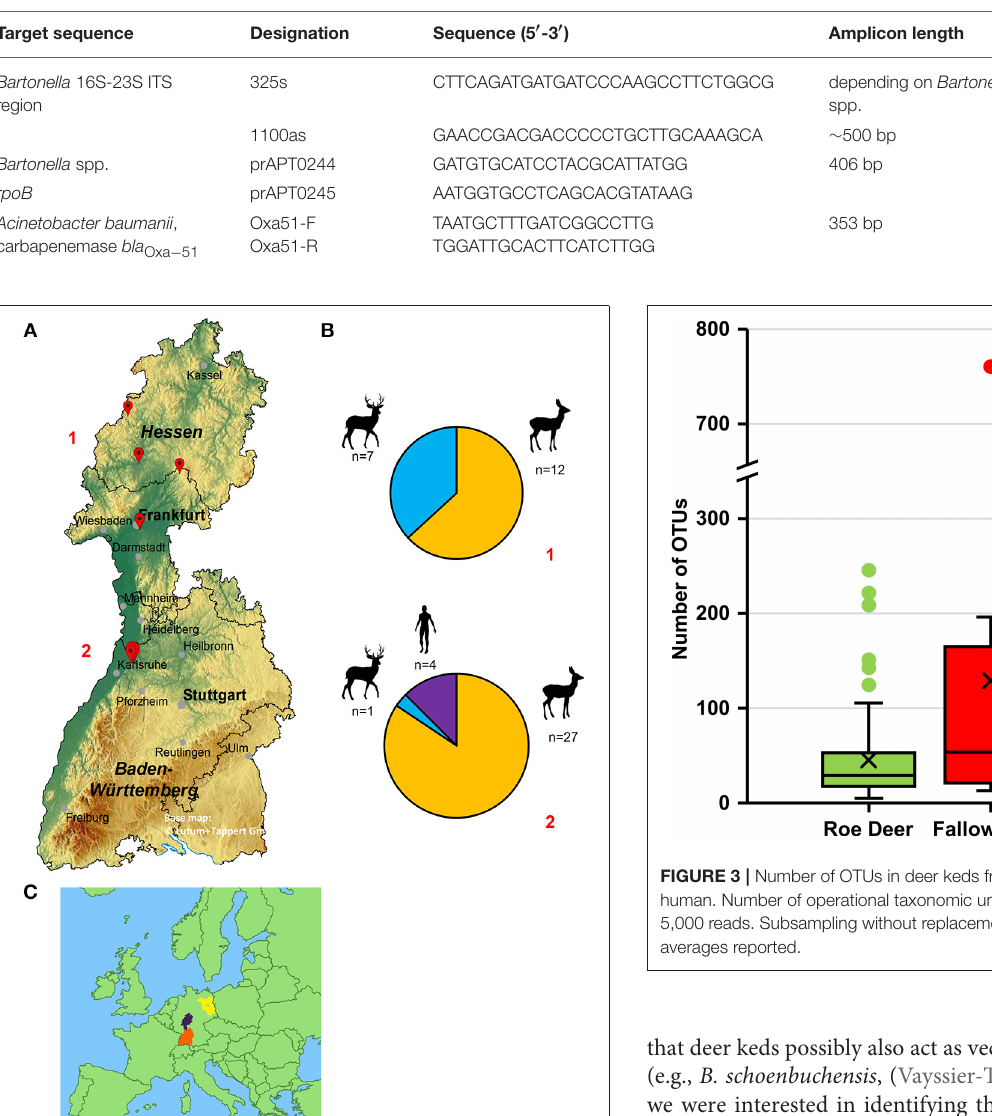
TABLE 1 | Targets, primers and amplicon sizes of the PCR-testing from deer keds, blood and muscels.